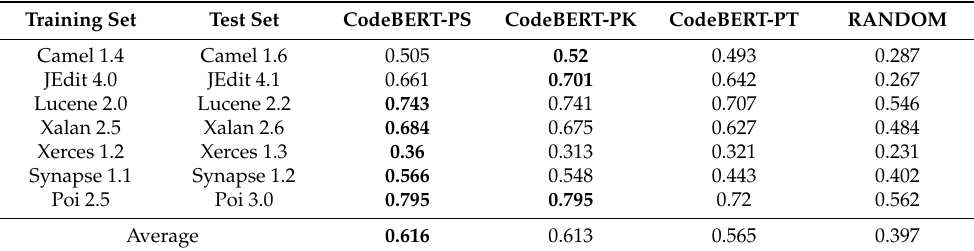
Table 5. Performance comparison of CodeBERT-PS, CodeBERT-PK, CodeBERT-PT, and RANDOM models on the CVPSC dataset for cross-version defect prediction. The float values are the average F-measure values. The best F-measure values are highlighted in